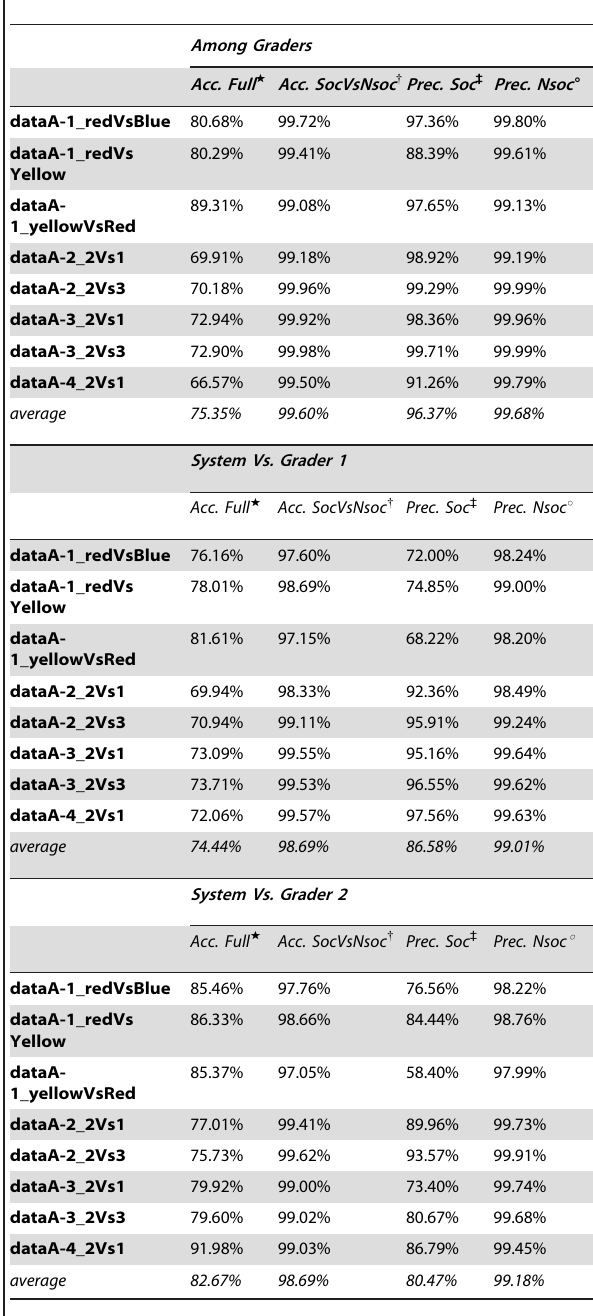
Table 2. Behaviour agreement among the two graders (top section) and quality of the system compared to the two graders (middle and bottom sections) on Dataset A (higher values are better